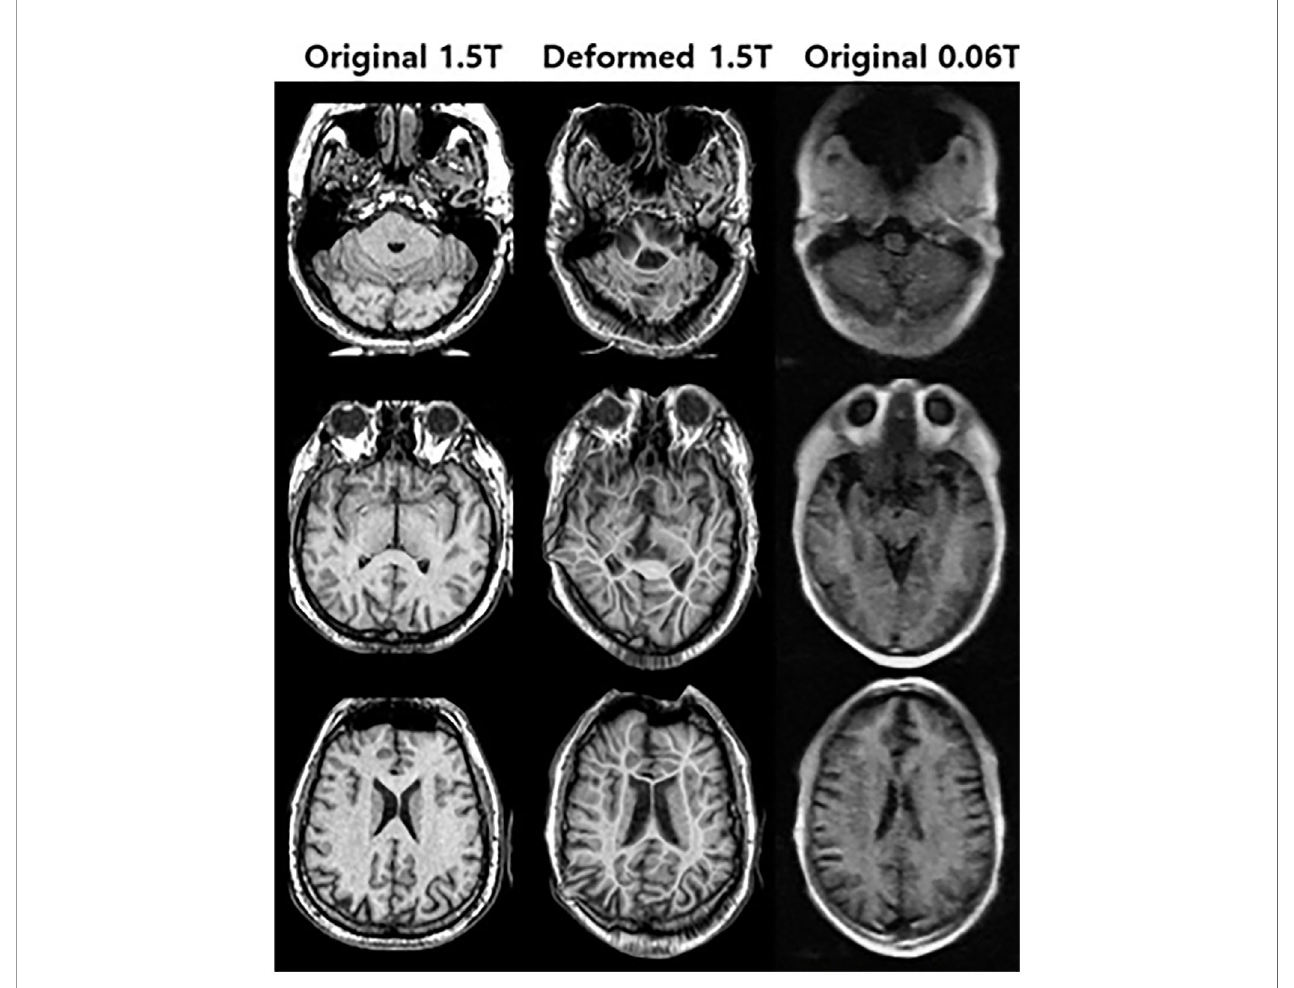
FIGURE 4 | Deformed 1.5 Tesla MR image from original 1.5 Tesla MR image according to 0.06 Tesla MR image in step 1 (deformable